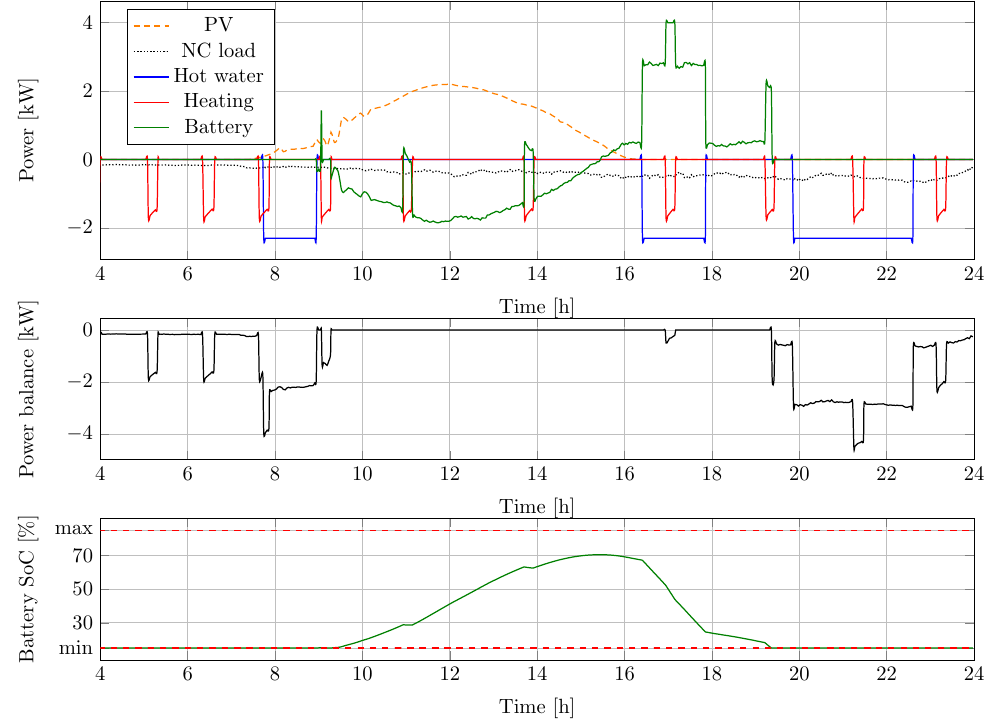
Figure 7. Power consumption/generation of devices for the winter sunny day